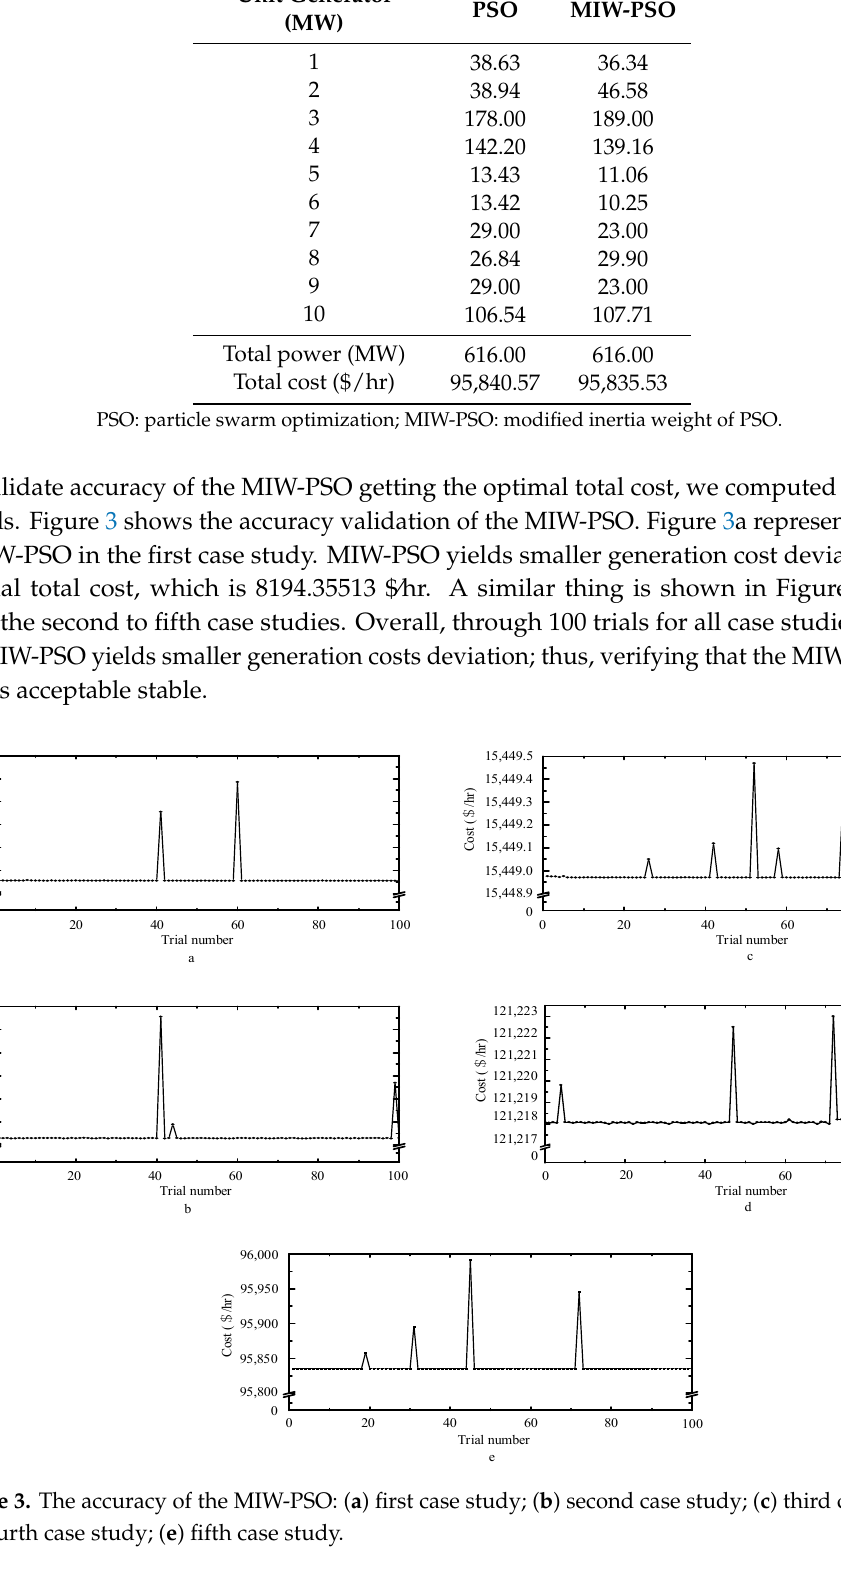
Table 14. Simulation result comparison on the fifth case study.